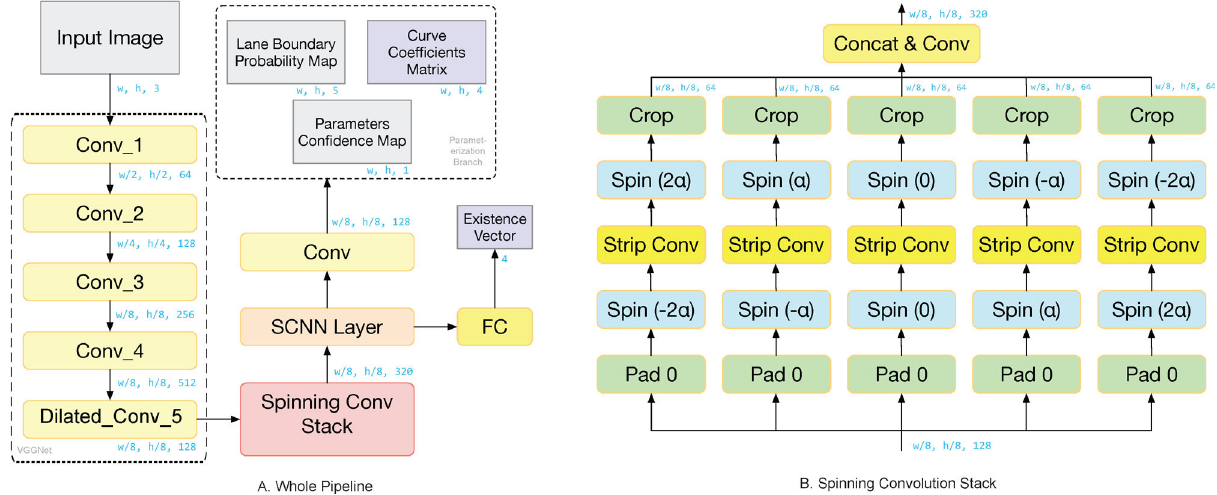
Fig. 1 The network structure of SpinNet and an illustration of the proposed spinning convolution. (A) shows the whole network structure of SpinNet, in which Conv 1 to Dilated Conv 5 are VGGNet backbone and the elements in dotted box and “Existence Vector” are the output of